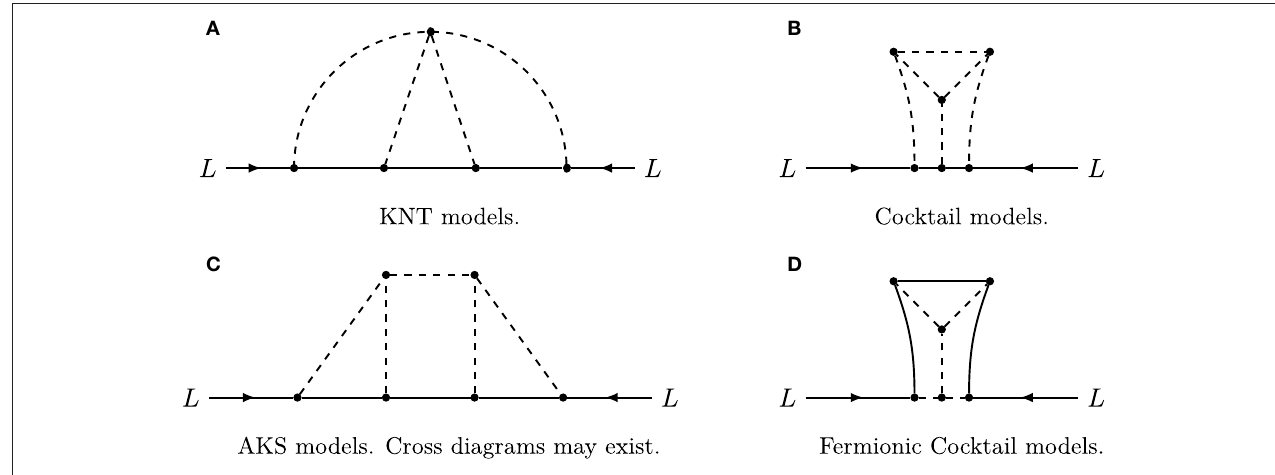
FIGURE 11 | 3-loop model topologies. Note that we do not specify the Higgs insertions.